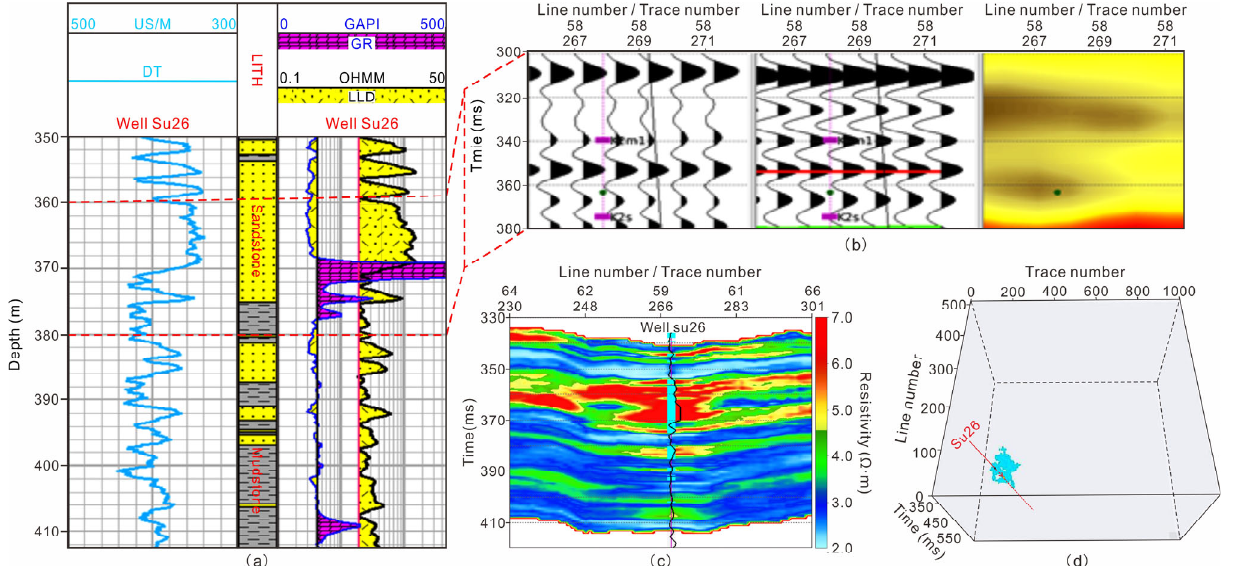
Figure 8. The detection of sub-body for sand-body with uranium: ( a , b ) The calibration of uranium anomaly in well, ( c ) Determination of the position of abnormal uranium section in the 3D inversion data volume, ( d ) The detection of sub-body in 3D inversion data